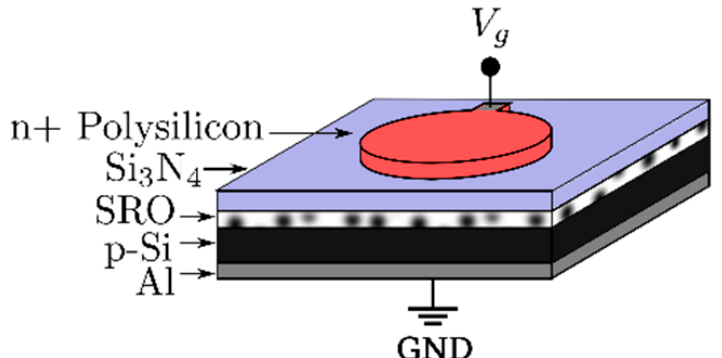
Figure 2. Light Emitting Capacitor stack structure based on SRO/Si